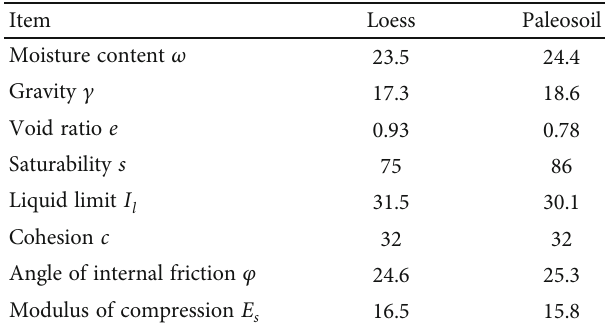
Table 4: Physical and mechanical properties of the prototype soil.